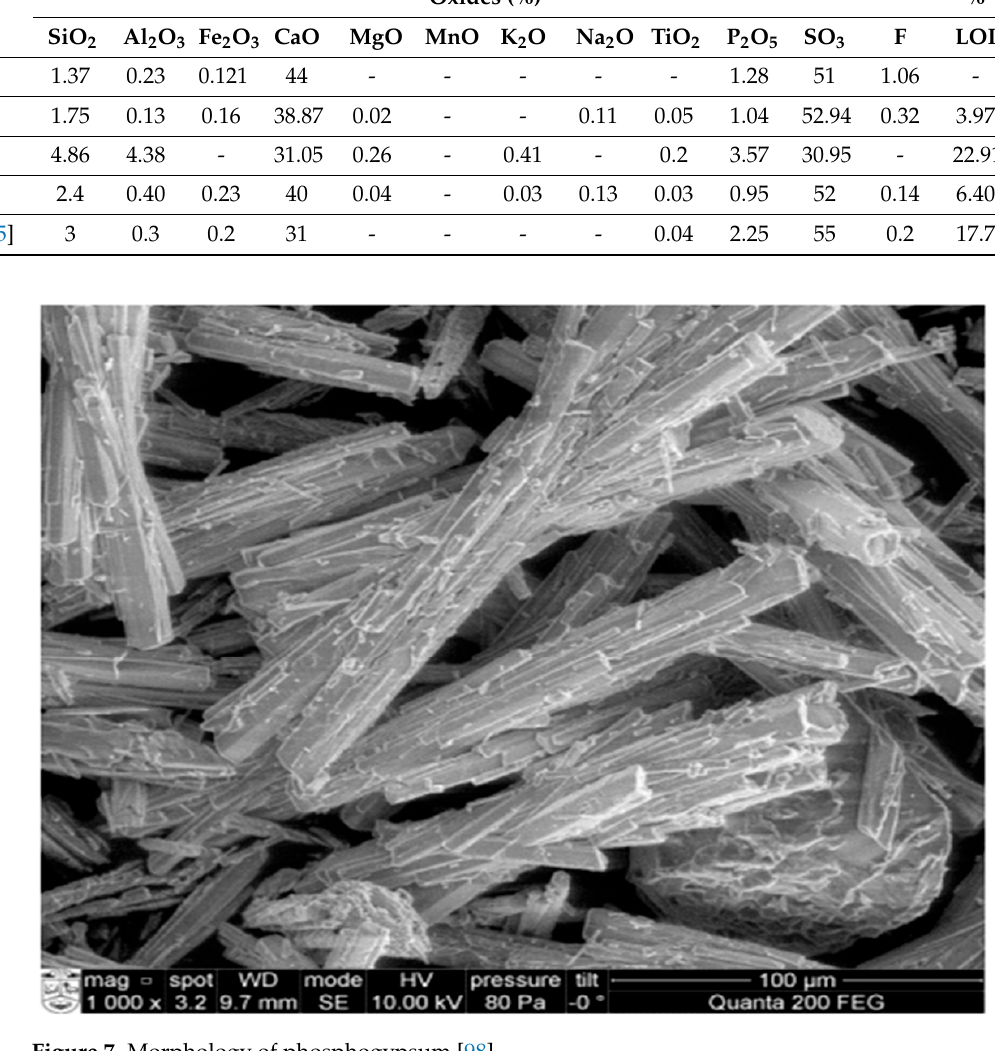
Figure 7. Morphology of phosphogypsum [98].